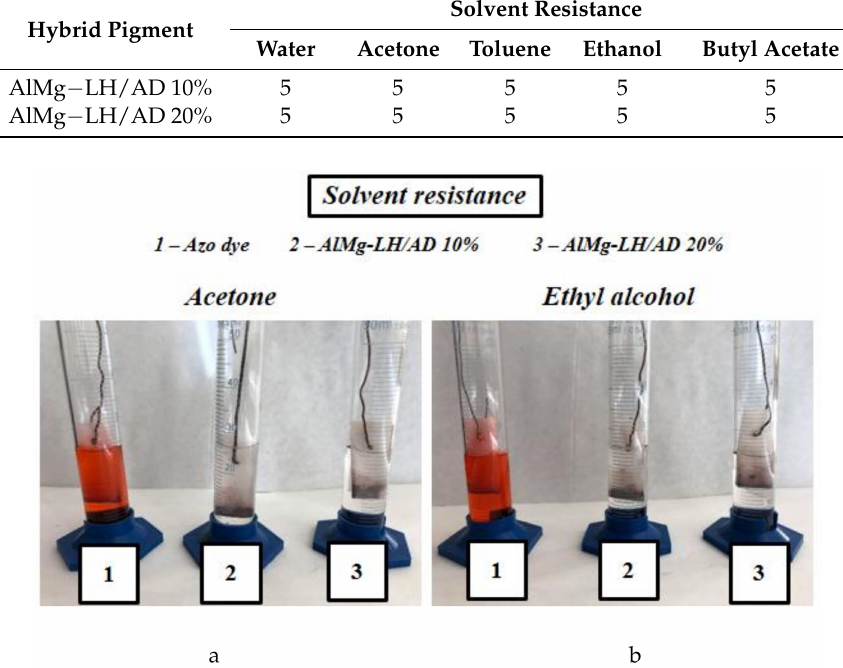
Figure 8. Digital images of AD dye, AlMg − LH/AD10%, and AlMg − LH/AD 20% after 24 h of immersion in acetone ( a ) and ethyl alcohol ( b